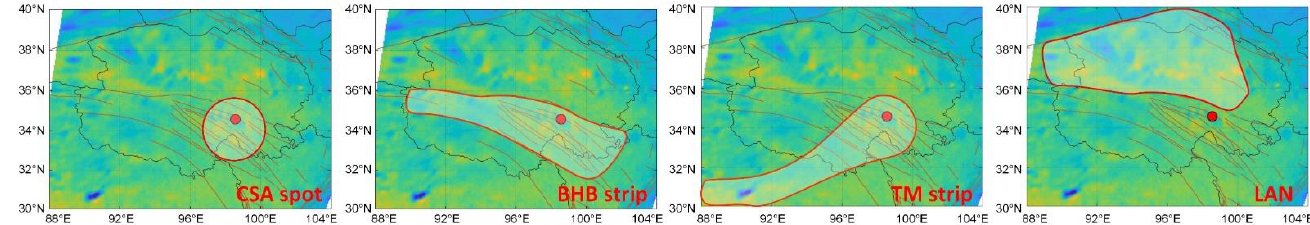
Figure A1. The four areas used to calculate the mean MBT residuals of the CSA spot, BHB strip, TM strip and LAN, respectively.